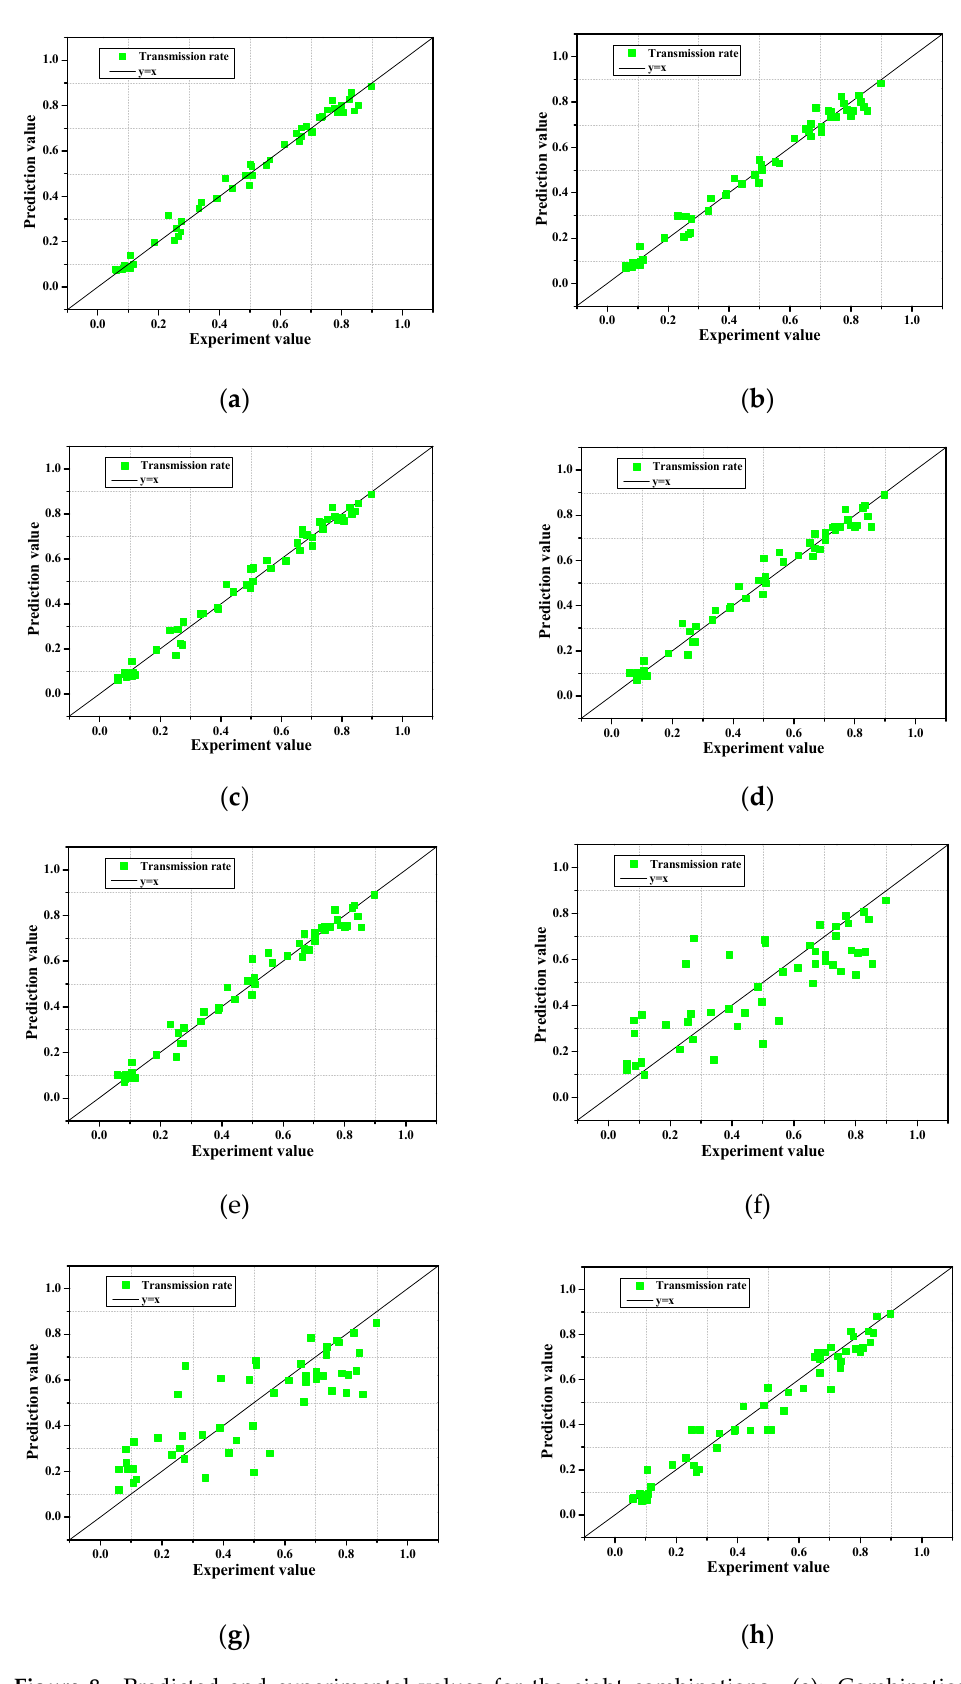
Figure 8. Predicted and experimental values for the eight combinations. ( a ): Combination 1; ( b ): Combination 2; ( c ): Combination 3; ( d ): Combination 4; ( e ): Combination 5; ( f ): Combination 6; ( g ): Combination 7; ( h ): Combination 8 .